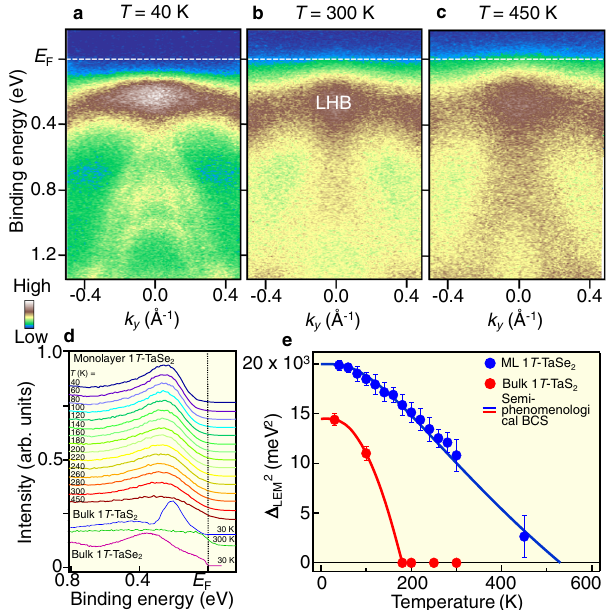
Fig. 2 CDW – Mott phase of monolayer 1T-TaSe 2 robust against temperature variation. a - c Near- E F ARPES intensity along the Γ K cut measured at T = 40, 300, and 450 K, respectively. d Temperature dependence of EDC at the Γ point. EDC for bulk 1T-TaS 2 ( T = 30 and 300 K) and bulk 1T-TaSe 2 ( T = 30 K) is also shown as a reference. e Squared leading-edge midpoint Δ LEM at the Γ point plotted against T for monolayer 1T-TaSe 2 (blue circles), together with the numerical fi tting results with the semiphenomenological (blue solid curve) BCS gap functions. Δ LEM and fi tting results are also plotted for bulk 1T-TaS 2 (red). We have obtained { T CDW-Mott , A } = {530 K, 1.01} and {180 K, 1.50} for monolayer 1T-TaSe 2 and bulk 1T-TaS 2 , respectively. Error bars in e re fl ect the uncertainties originating from the energy resolution and the standard deviation in the peak positions of